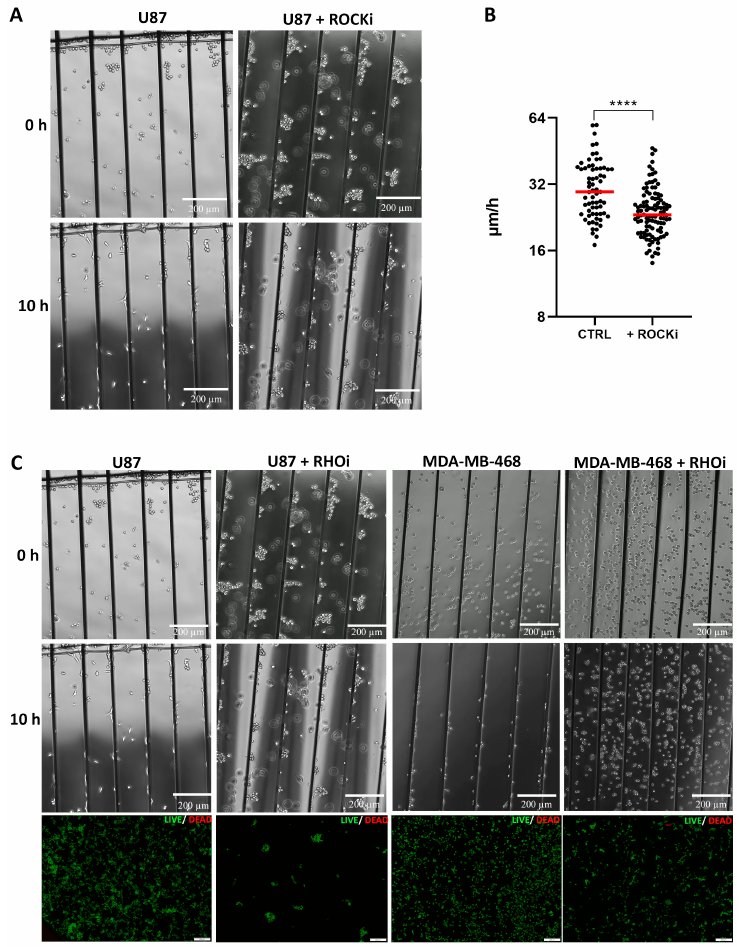
Figure 6. RHO ‐ ROCK regulates tumor cell durotaxis and migration. ( A ) Representative images of U87 PTEN loss of function control cells (left) or cells treated with the ROCK inhibitor (ROCKi) Y ‐ 27632 at 0 h and 10 h on laminin ‐ coated aligned microfibers. ( B ) Migration speed ( μ m/h) of U87 cells (control, CTRL) ( n = 7 experiments; n = 67 cells) vs. U87 cells with the ROCK inhibitor (ROCKi)Y ‐ 27632 ( n = 9 experiments, n = 107 cells); **** p < 0.0002. ( C ) Representative images (from left to right) of U87 control (1st column) or cells treated with RHO inhibitor (RHOi) (2nd column) and MDA ‐ MB ‐ 468 PTEN wt cells control (3rd column) or treated with the RHO inhibitor (RHOi) (4th column) on aligned microfibers coated with laminin at 0 h and 10 h (U87: n = 4 experiments; MDA ‐ MB ‐ 468: n = 3 experiments). Lower panels are examples of cell viability analyses of the respective tumor cells above after RHO inhibitor treatment. Green: live cells; red: dead cells.